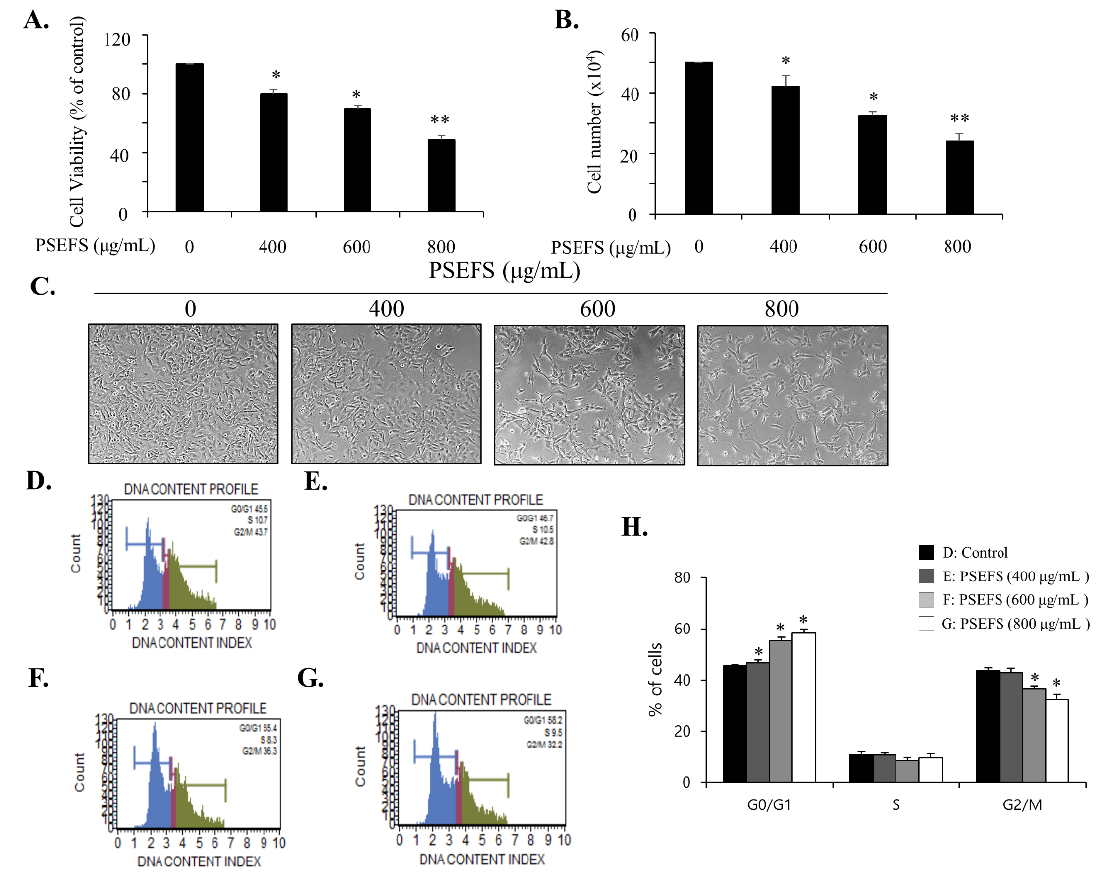
Figure 1. Peanut sprout extracts cultivated with fermented sawdust medium (PSEFS) inhibits T24 cell proliferation via G1-phase arrest. ( A ) Cells were exposed to di ff erent concentrations of PSEFS (0, 400, 600, and 800 µ g / mL) for 24 h, and an MTT assay was performed to evaluate cell viability. ( B ) Cell counting was performed to determine cell growth. ( C ) Morphological changes of cells according to phase-contrast microscopy (40 × ). ( D – G ) The cell cycle distribution of T24 cells treated with the indicated concentrations of PSEFS for 24 h and evaluated by flow cytometry analysis. ( H ) The percentage of the cell population in specific cell cycle phases. Data represent the mean ± SD of triplicate experiments. * p < 0.05, ** p < 0.01 vs. control.